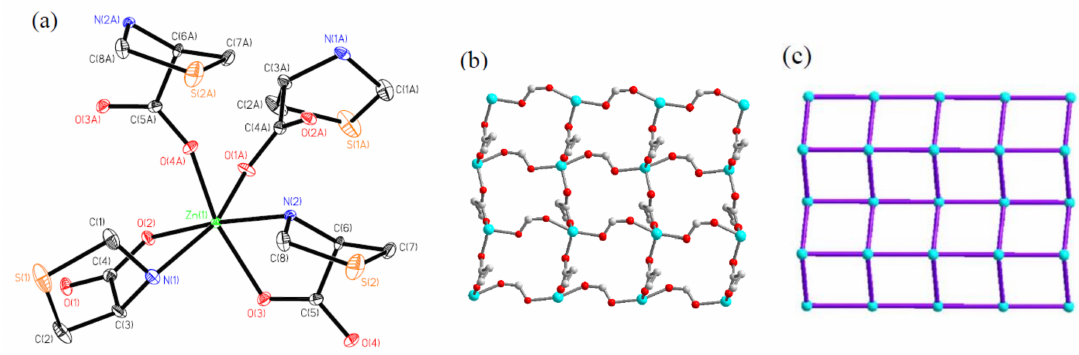
Figure 4. Structures of compound 3 : ( a ) the coordination environment of Zn(II) ion; ( b ) a simplified 2D homochiral layer with the Zn(II) ions and the carboxylate motifs from the tpro − ligands in the ab plane, while the other motifs are omitted for clarity; ( c ) a 2D layer structure with a (4,4)